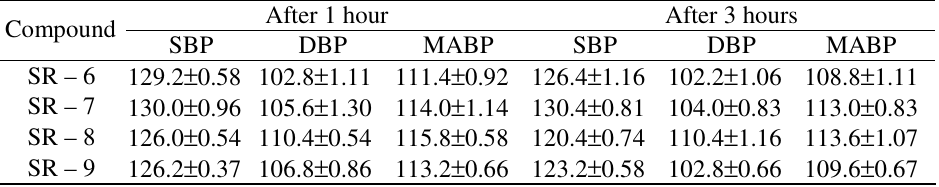
Table 3 . Reduction in blood pressure (mean ± SEM) at a dose of 50 µ gm/kg animal body weight After 1